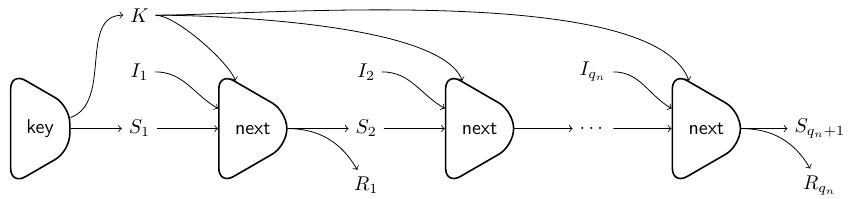
Figure 9: Pseudo-Random Number Generator with Input [DHY02]